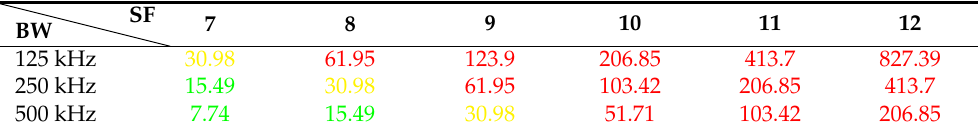
Table 2. Packet transmission time in ms, in dependence of BW and SF, with CR = 1. Values represented in green are compliant with the logic selectivity implementation, while red values are not. Yellow values are very close to the considered time threshold, and the corresponding LoRa configurations turn out to be unreliable for the